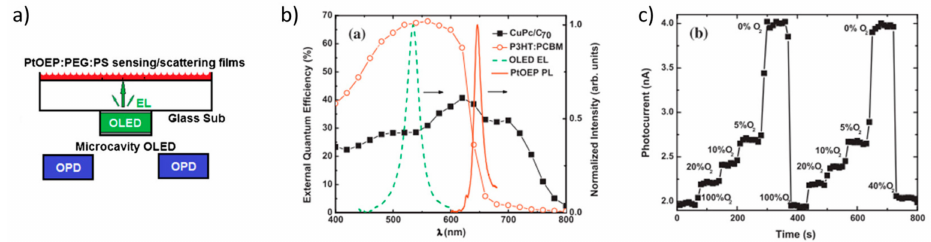
Figure 9. O 2 sensor based on a back-to-back integration of a microcavity organic light emitting diode (OLED) and two organic light photodiodes (OPDs) by using Platinum(II) 2,3,7,8,12,13,17,18-octaethyl-21H,23H-porphyrin (PtOEP) in a polymeric matrix of PEG-PS as sensing element ( a ). The external quantum e ffi ciency (EQE) of CuPc / C 70 (black squares) and P3HT:PCBM-based OPDs (red dots) are reported with the EL (dashed green line) and PL (red line) characteristics of the OLED and the PtOEP sensing element, respectively ( b ). The signal of the O 2 sensor is reported at di ff erent analyte concentrations ( c ). Reprinted from [156], © 2020, with permission from